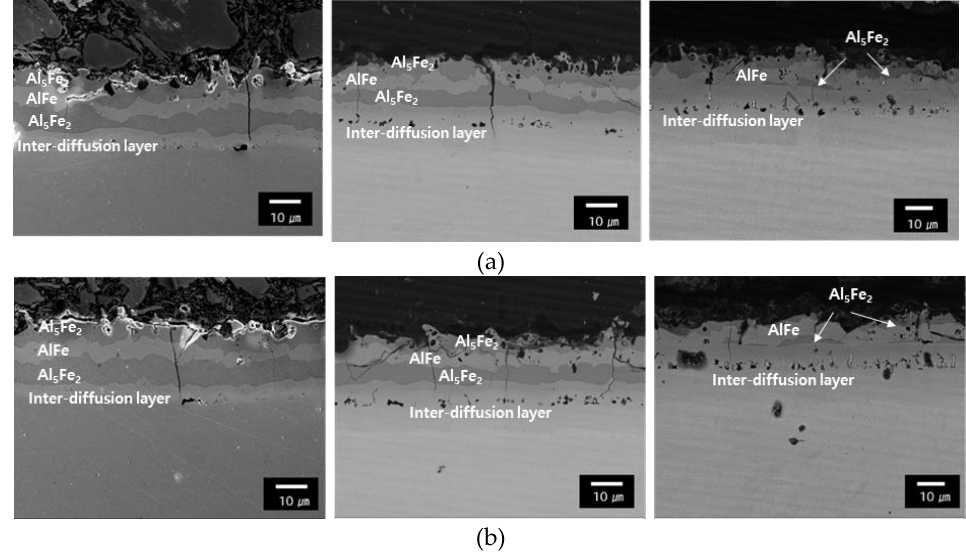
Figure 4. SEM images of coating: ( a ) the 1.5 GPa grade steel austenitized during 150 s, 300 s, and 450